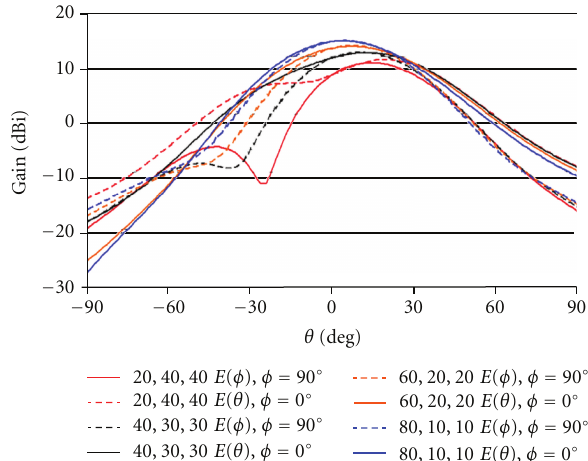
Figure 5: Phase distribution for the triple-mode feedhorn at 7.73